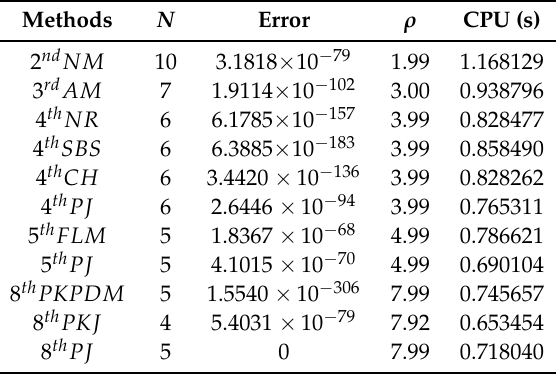
Table 9. Comparison of results for Application